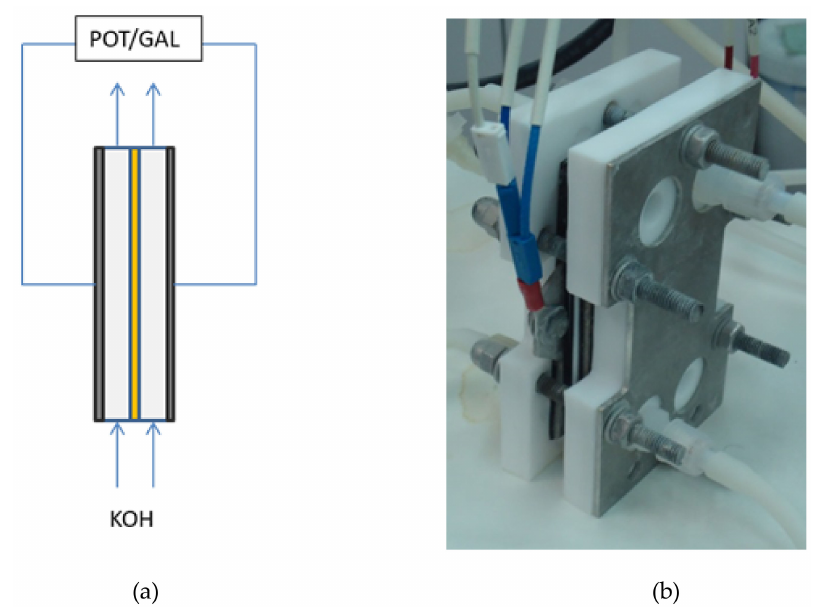
Figure 4. Electrochemical Impedance Spectroscopy (EIS)-Method Setup: ( a ) Scheme ( b ) Real